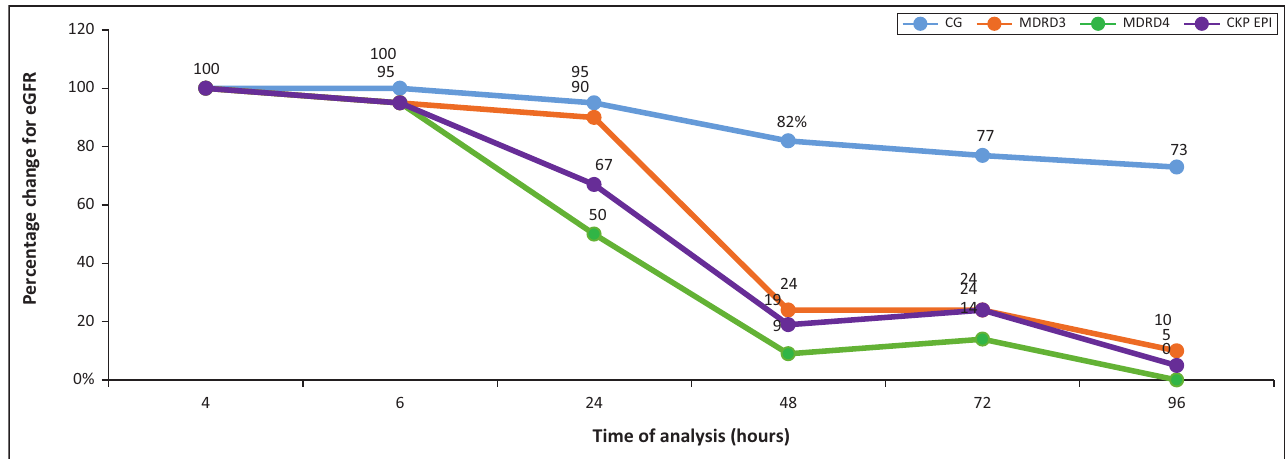
FIGURE 5: Percentage change of estimated glomerular filtration rate classification based on kinetic Jaffe creatinine concentrations over the 96-h study period compared to estimated glomerular filtration rate obtained within 4 h using the Cockcroft-Gault, Modifications of Diet in Renal Disease v3, Modifications of Diet in Renal Disease v4, and Chronic Kidney Disease-Epidemiology equations. blue = CG, orange = MDRD3, purple = CKD, green = MDRD4.